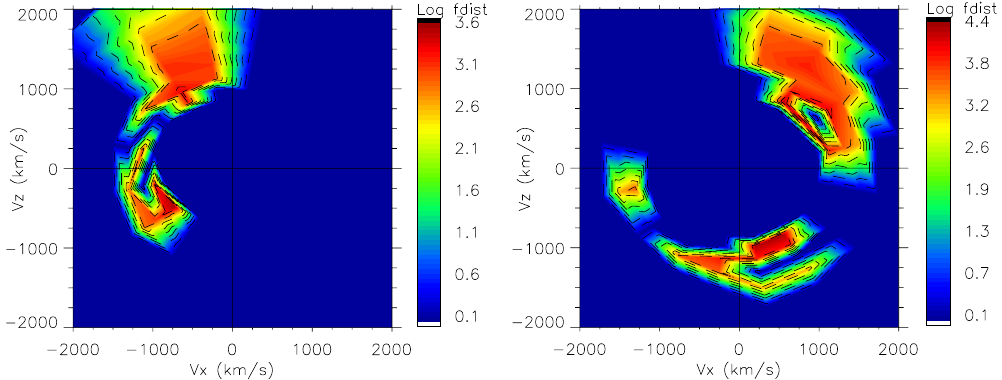
Fig. 6. Proton distribution functions projected in the (v x ,v z ) plane measured by C 1 averaged during the time intervals indicated on Fig. 4 (left:blue, right:red).